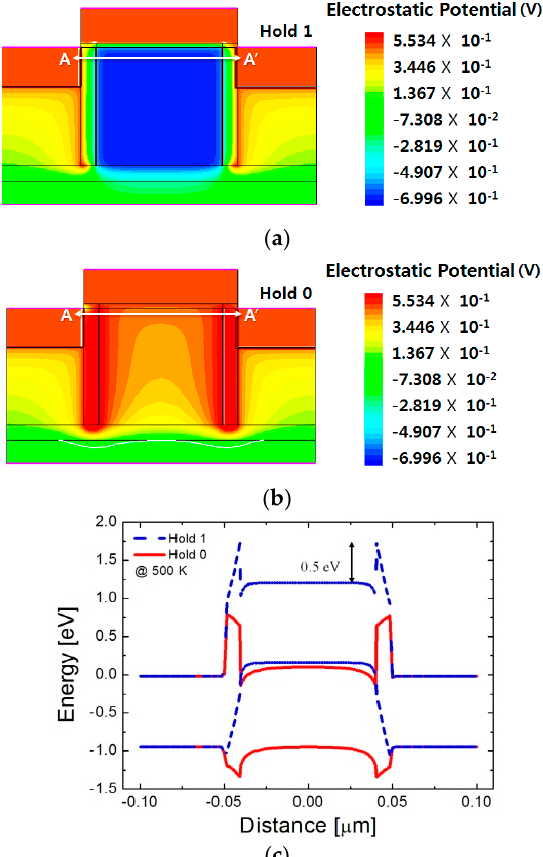
Figure 5. Verification of hold operation. ( a ) Potential distribution under the hold-1 condition; ( b ) potential distribution under the hold-0 condition; ( c ) energy-band diagrams under the hold-1 and the hold-0 conditions along the A-A’ cutline in ( a ).